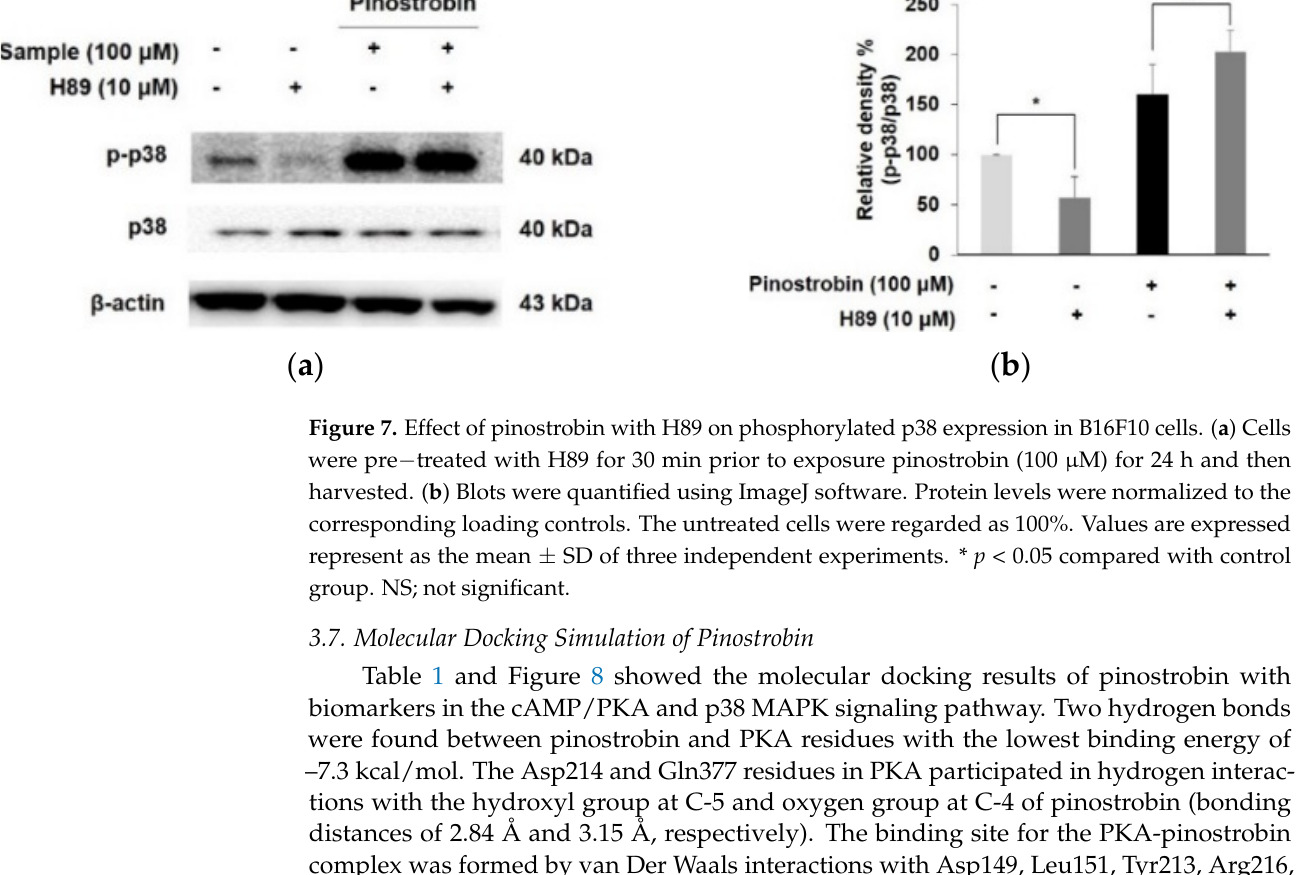
harvested. ( b ) Blots were quantified using ImageJ software. Protein levels were normalized to the corresponding loading controls. The untreated cells were regarded as 100%. Values are expressed represent as the mean ± SD of three independent experiments. * p < 0.05 compared with control group. NS; not significant.